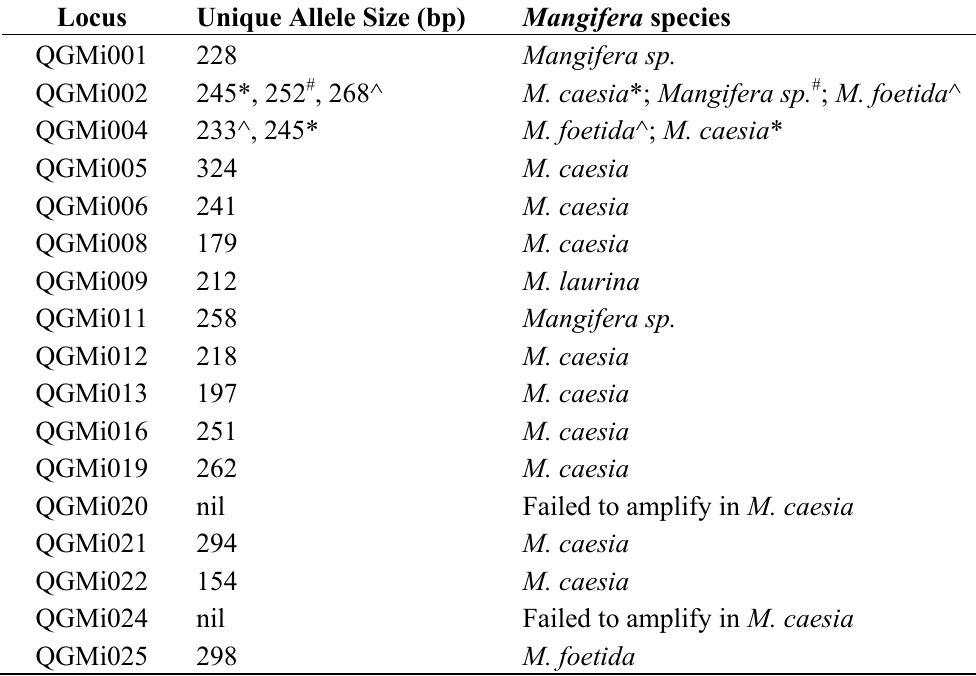
Table 4. Private alleles within the five Mangifera species analyzed.